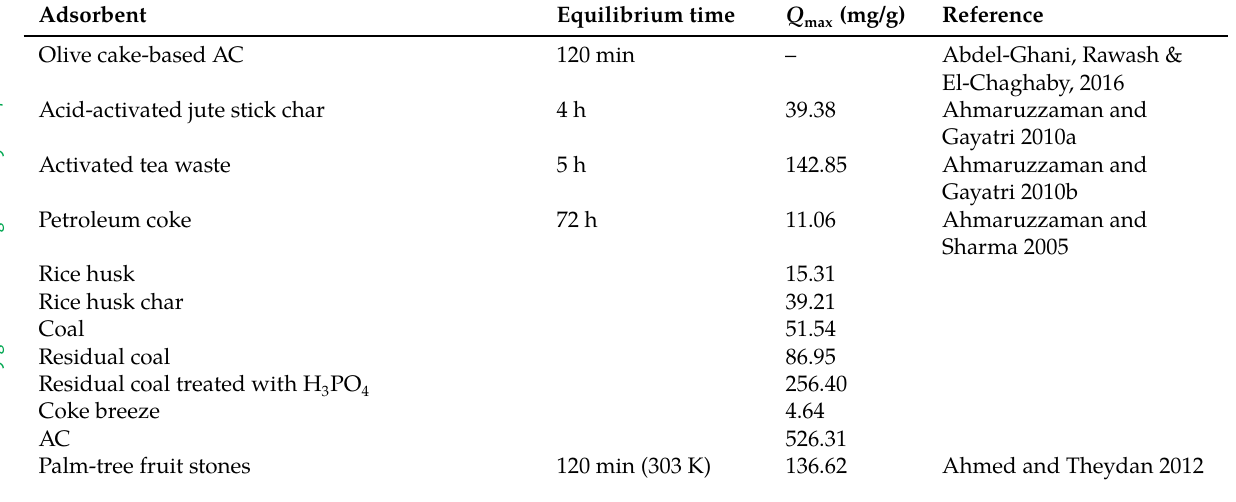
Table 3: Adsorption of p -NP onto pristine and modified adsorbents.